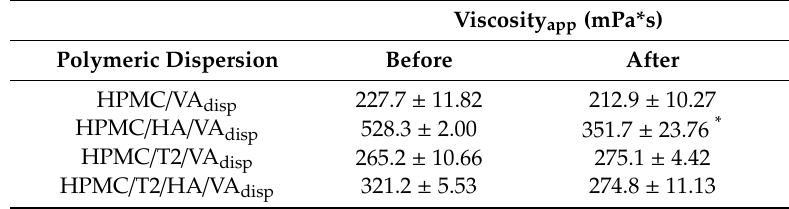
Table 4. Apparent viscosity values before and after the freeze-drying process, Mean ± SE; n =